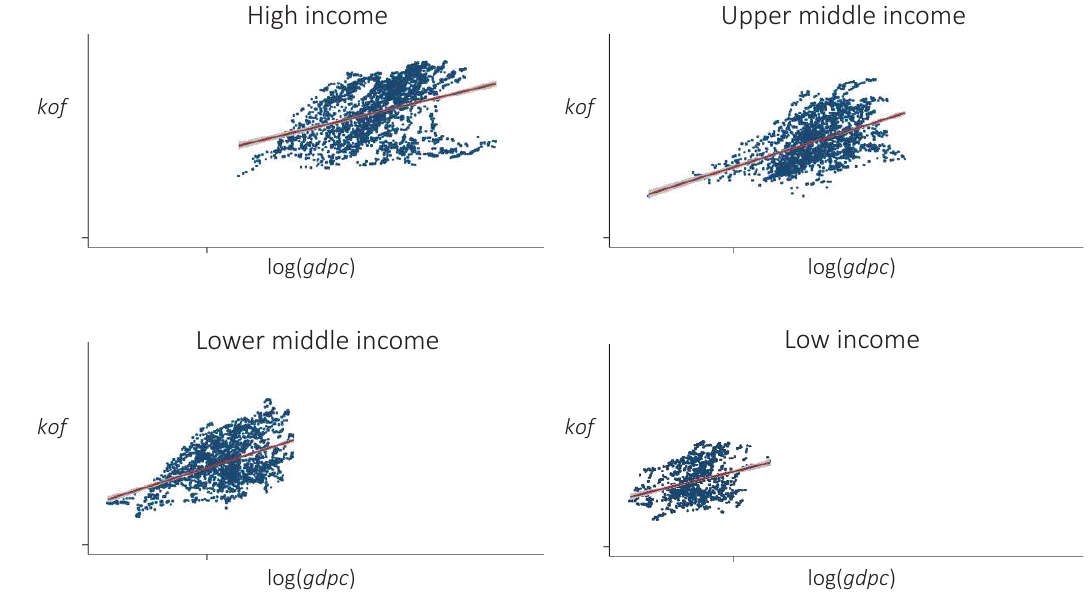
Figure 2. GDP per capita in the world and the KOF